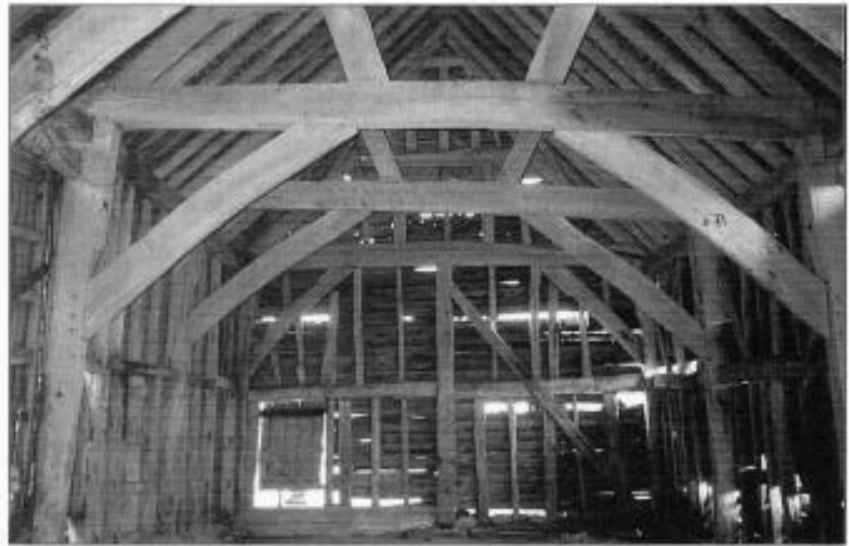
Figure 6 View of the east end of the south barn at Home Farm, Newdigate, Surrey.